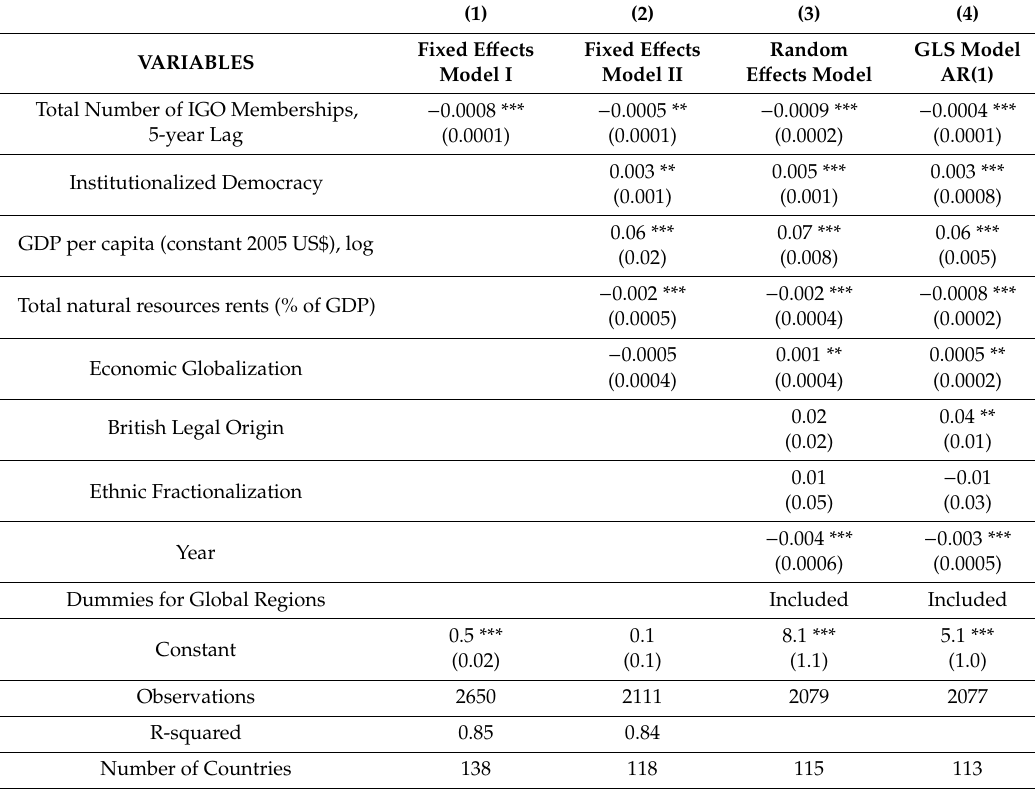
Table 1. The e ff ects of the number of international governmental organization (IGO) memberships on the International Country Risk Guide (ICRG) indicator of quality of government. Cross-section time-series models